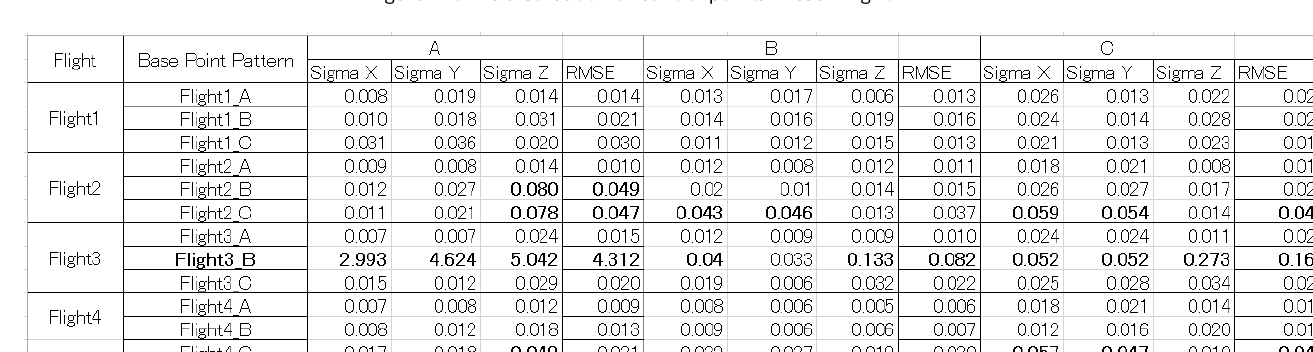
Figure 11. The distribution of control points in each flight